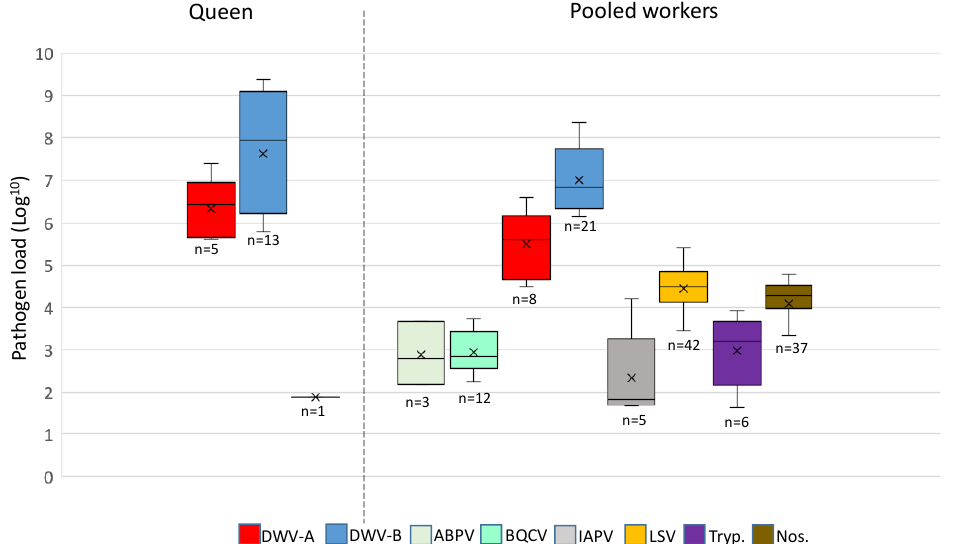
Figure 3. A comparison of the pathogen load (log 10 ) in positive queens and pooled worker samples. Whiskers show the minimum and maximum range, horizontal lines within the boxes represent the median pathogen load, and X designates the mean pathogen load.